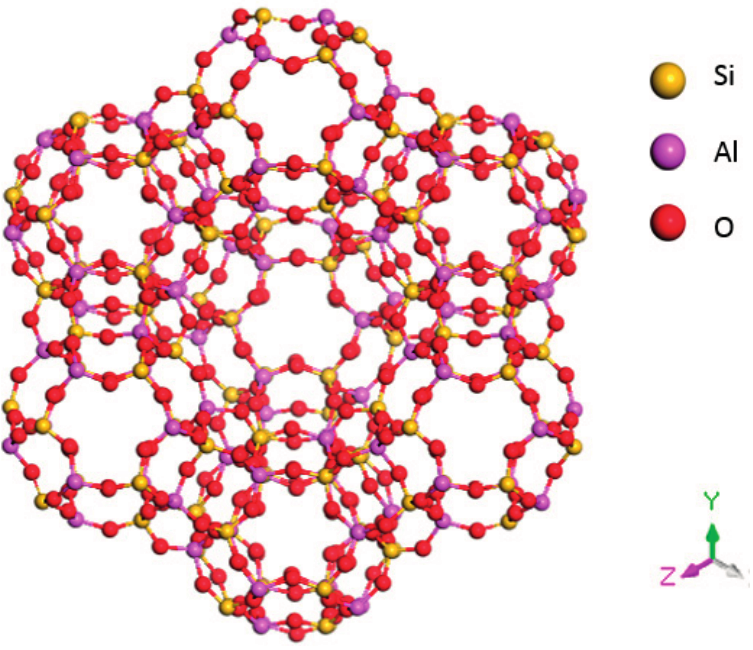
Figure 2. Structural model of an X-type molecular